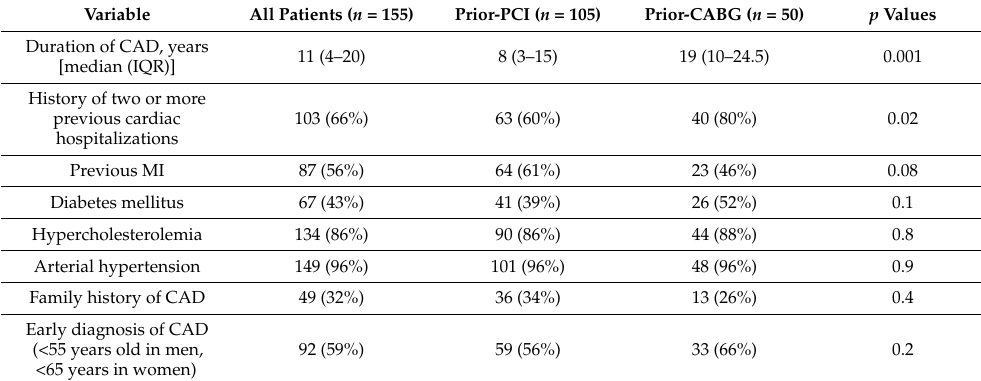
Table 2. Comparison of clinical